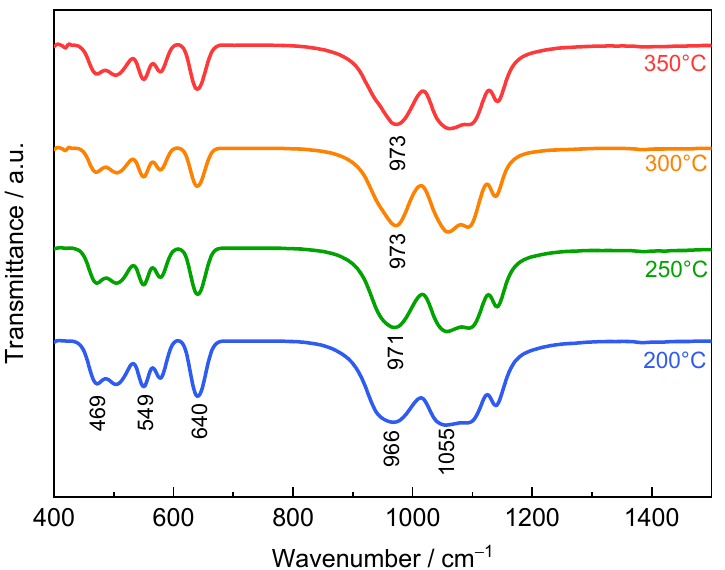
Figure 7. FTIR spectra of LiFePO 4 samples prepared at spray drying temperature of 200 °C, 250 °C, 300 °C and 350 °C.